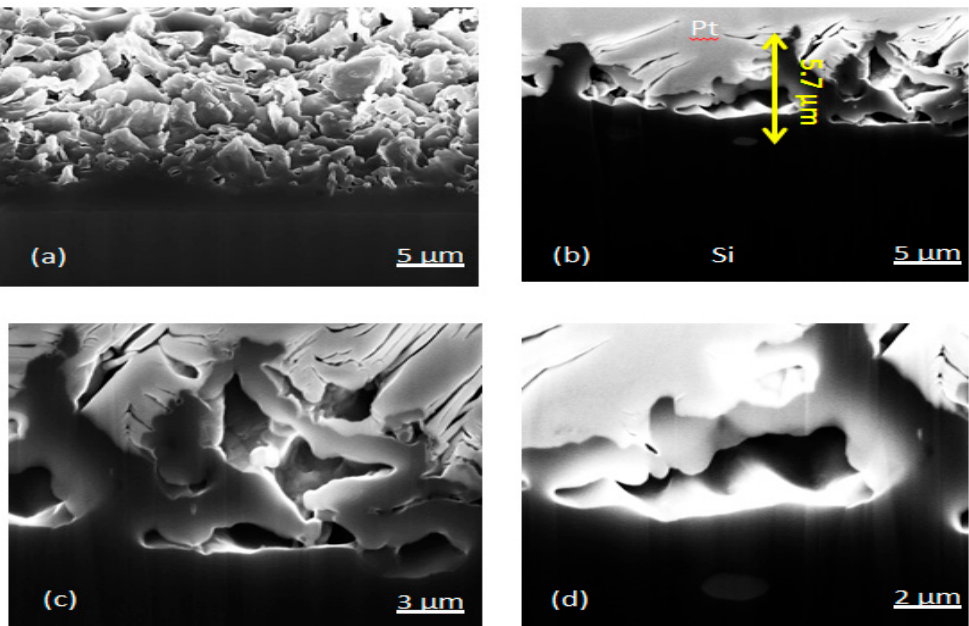
Figure 8. FIB-SEM cross-sectional images of the as-etched silicon nanoflakes: ( a ) low magnification without Pt coating, ( b ) low magnification with Pt coating, ( c ) large magnification showing micropores and cavities, and ( d ) magnified SEM image of cross-section.